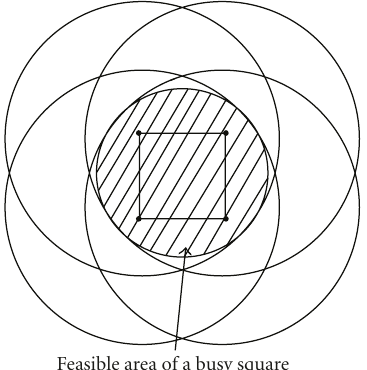
Figure 3: The feasible area to place the RN to cover one busy square. The 4 circles demarcate one region around the square, which can be approximated using a circle, shown as the shadow area.